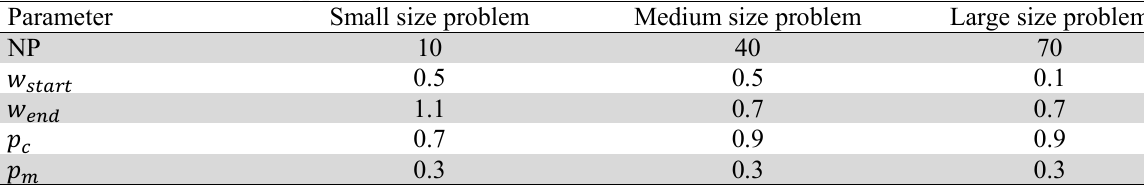
The levels of the values of each parameter for PSO Parameter/Level